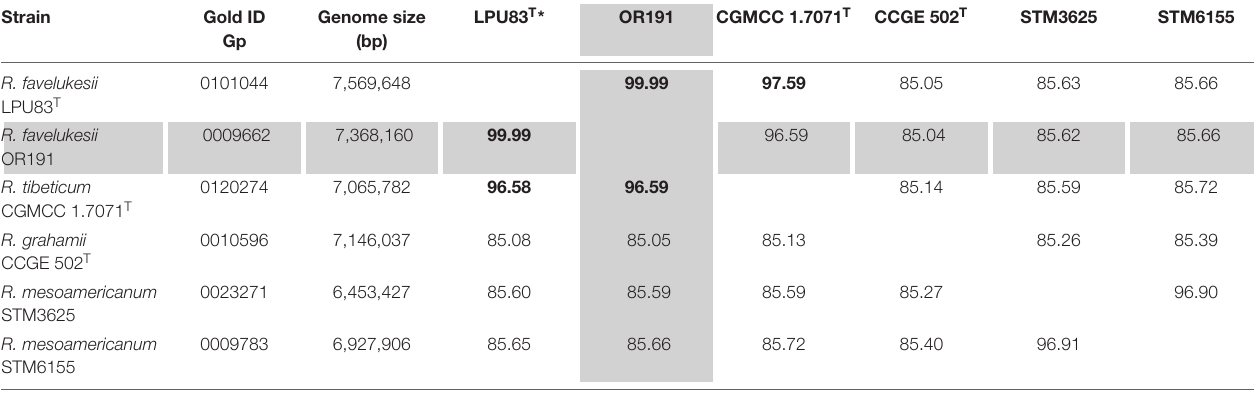
TABLE 3 | Pairwise comparisons of gANI values a of Rhizobium favelukesii OR191 (shaded) to selected Rhizobium strains in IMG.